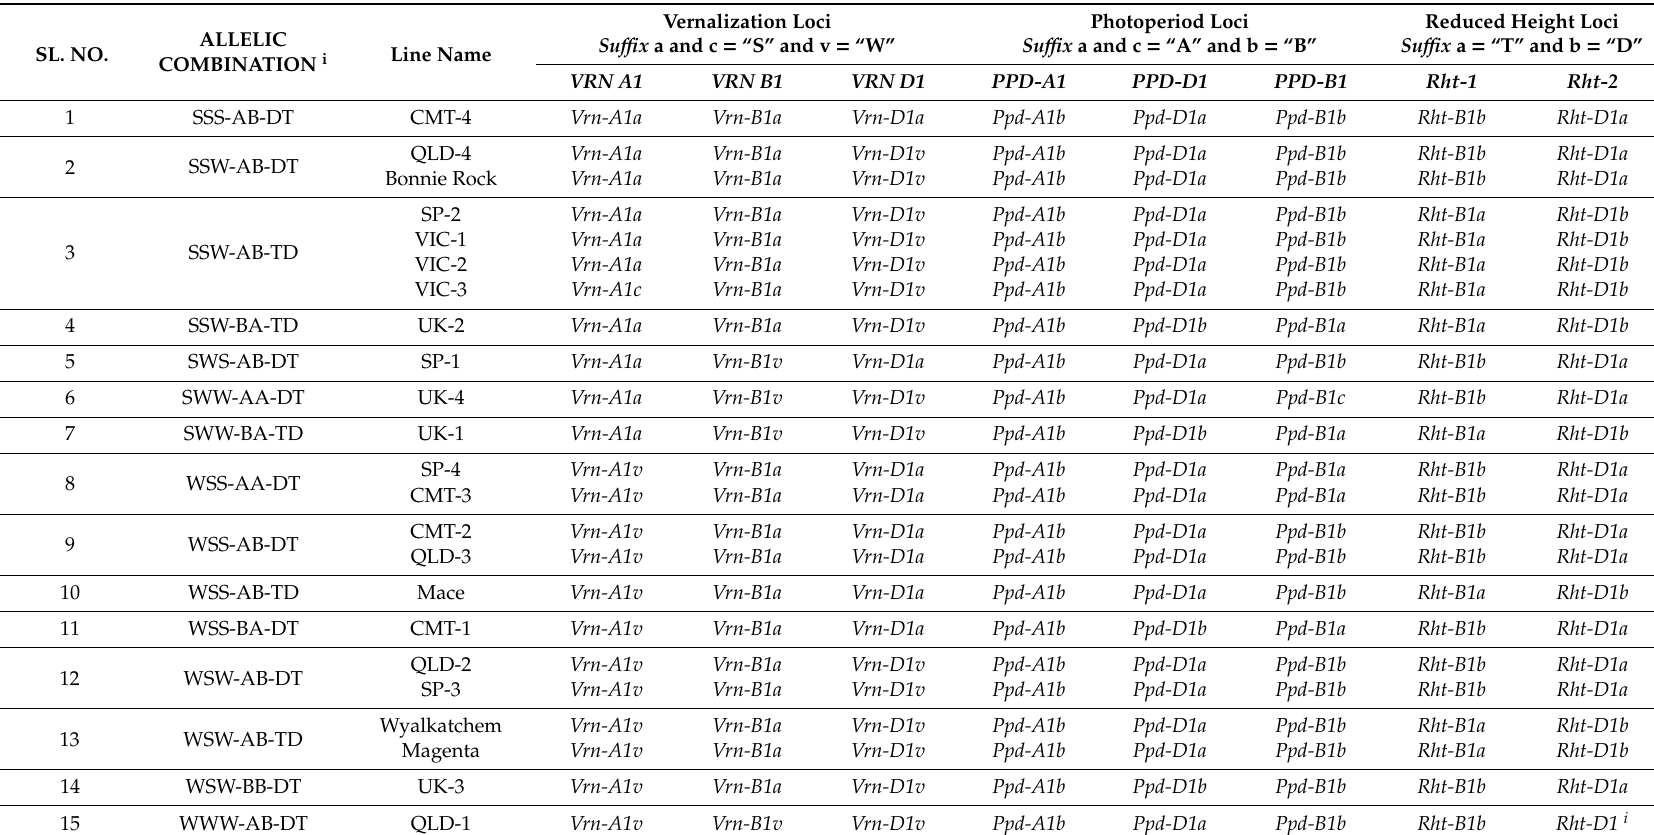
Table 1. Allelic composition of the advanced